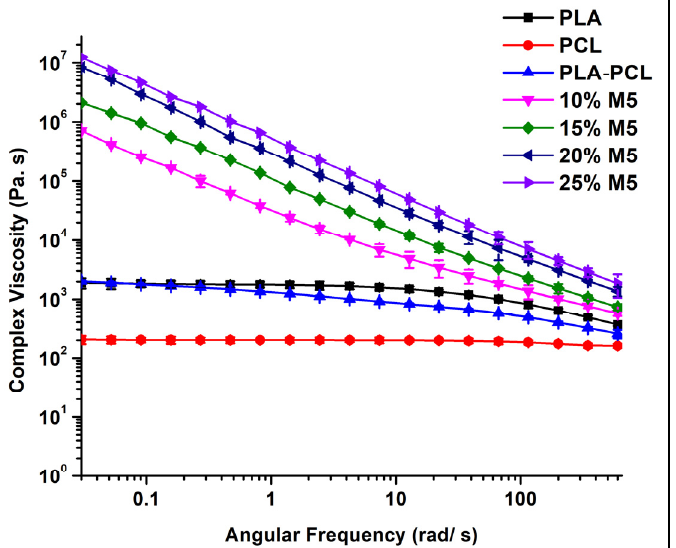
Figure 12. The complex viscosity curves of pure PLA and PCL polymers in addition to their blend and composites.